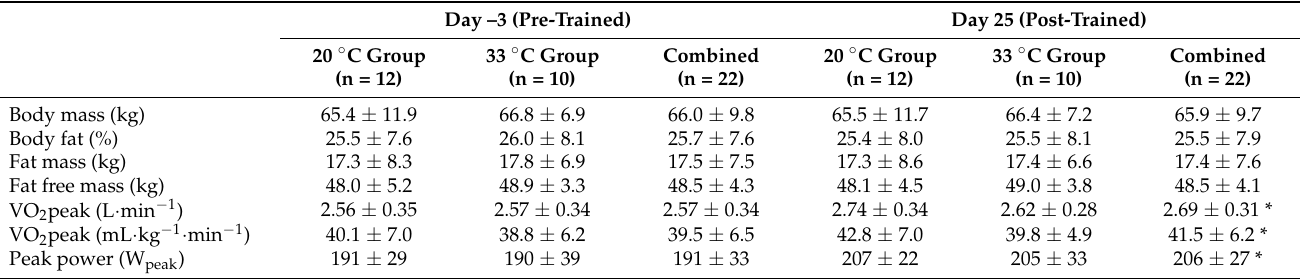
Table 2. Fitness Assessment Data (20 ◦